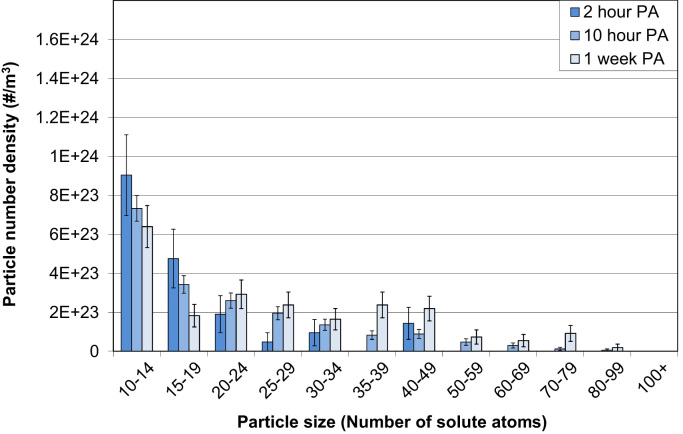
Particle number densities for different particle size ranges after 2 or 10 h or 1 week PA as measured by LAR-3DAP. A Nmin of 10 was used for particle analysis.